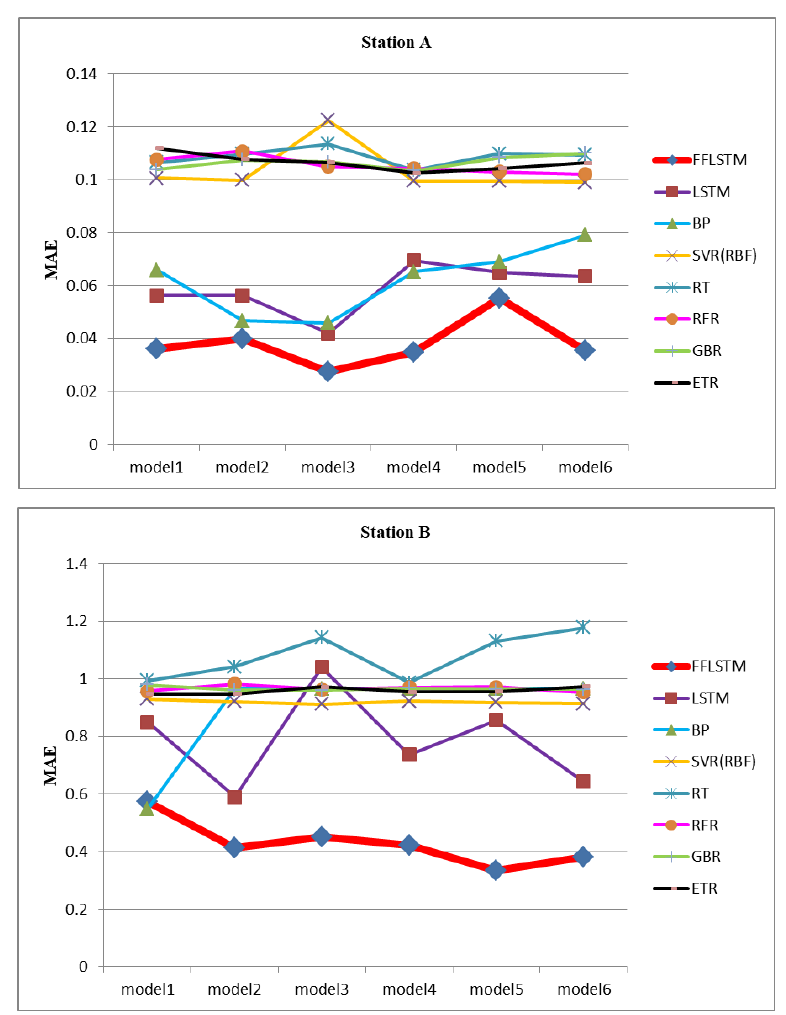
Figure 4. Evaluation of the results of the root-mean-square error (RMSE) for station A and B, respectively.